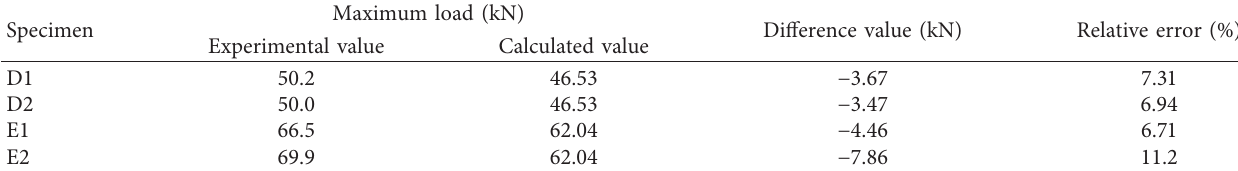
Table 4: Comparing the results of tests to those of